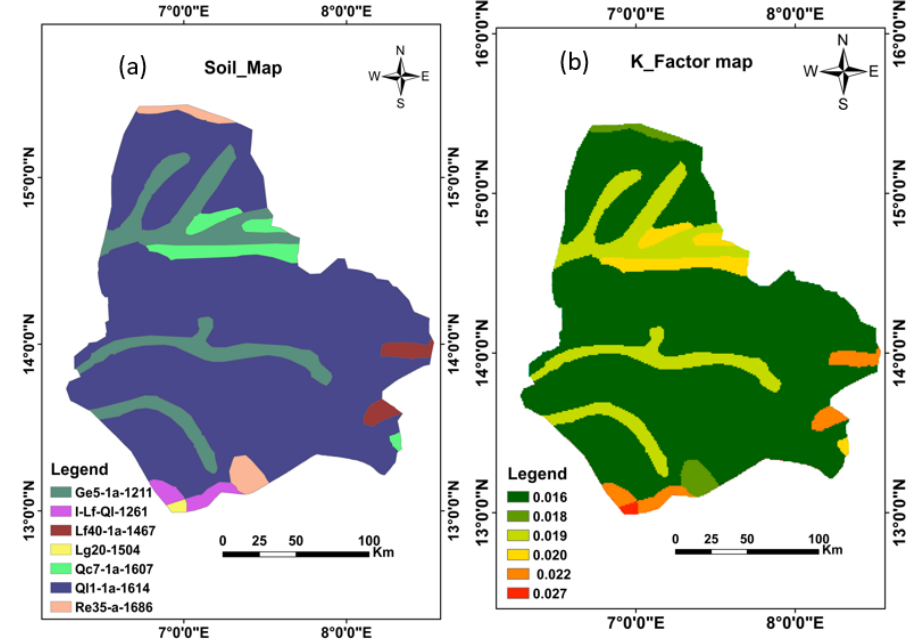
Figure 4. ( a ) Soil type and ( b ) soil erodibility (K-factor) maps.